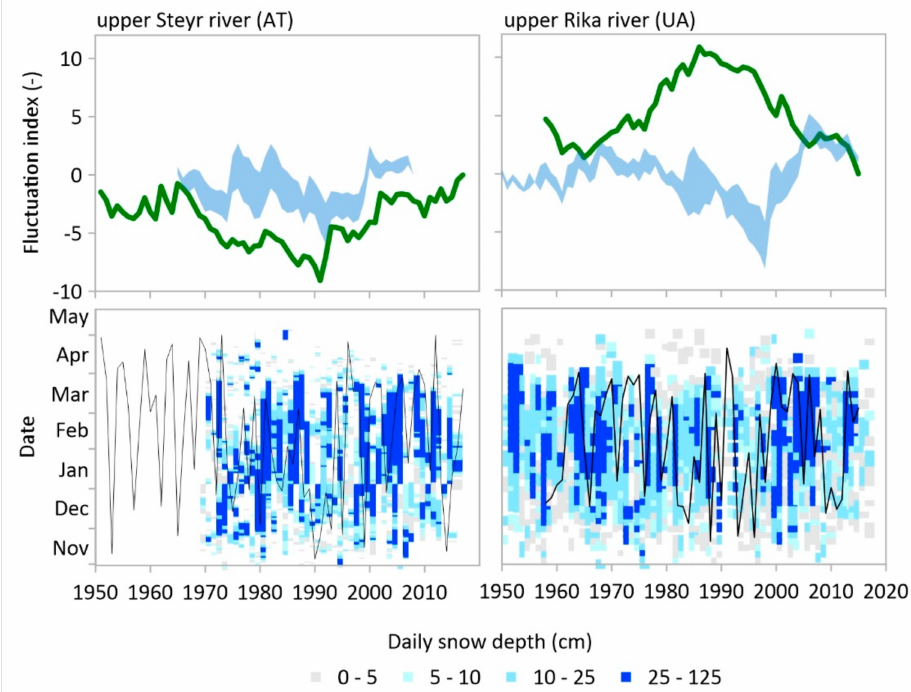
Figure 9. Fluctuations ( top panels) and seasonality ( bottom panels) of the winter floods and observed snow depth in the upper Steyr and the upper Rika catchments. Lines show fluctuation and seasonality of winter floods in the Steyr River − Klaus an der Pyhrnbahn ( left ) and Rika River − Mizhhiria village ( right ) catchments. Variability in snow depth fluctuation (blue band in top panels) is plotted for climate stations listed in Table 4. The green line indicates the fluctuation index of the winter floods ( top panels). Daily snow depth seasonality is presented for the Spital am Pyhrn (Austria, 630 m a.s.l.) and Nyzhnii Studenyi (Ukraine, 615 m